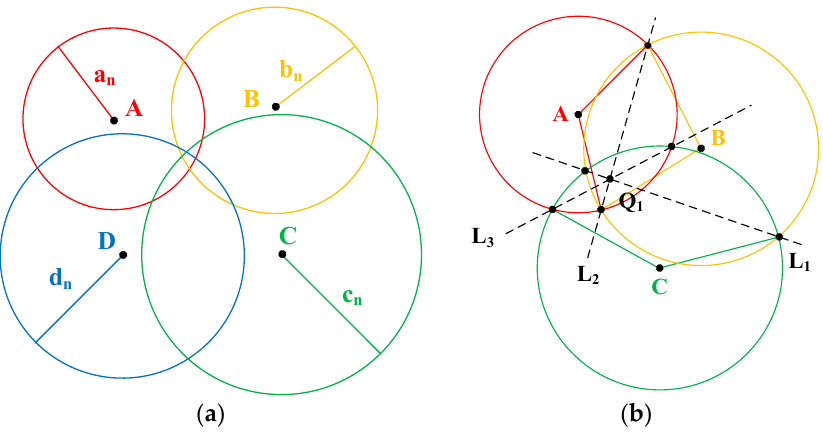
Figure 10. Position estimation using ( a ) quadrilateral localization and ( b ) trilateration localization.